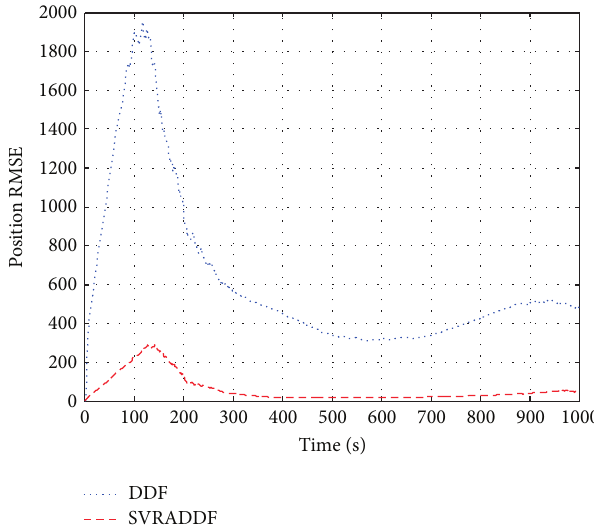
Figure 3: RMSE in position for DDF and SVRADDF.